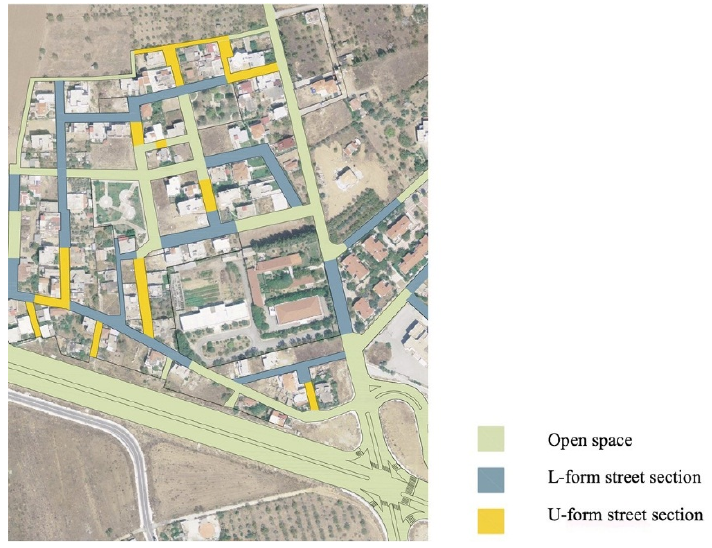
Figure 5. Urban typology